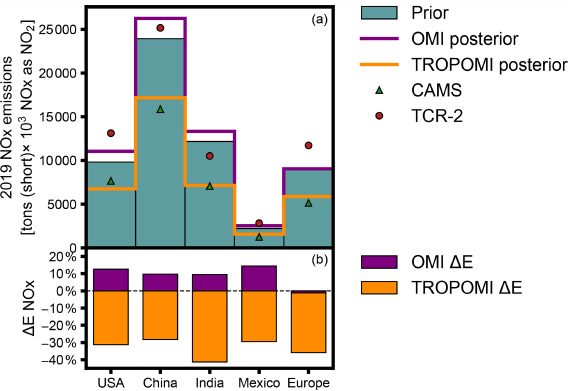
Figure 7. Prior and satellite-inferred 2019 anthropogenic NO x emissions in select global regions. Plot (a) shows total emissions (as NO 2 ) from prior emissions estimates, inference with OMI or TROPOMI observations (OMI and TROPOMI posterior), and CAMS or TCR-2 inventories in the US, China, India, Mexico, and Europe. Plot (b) shows the percent change ( (cid:49)E NO x ) inferred with OMI or TROPOMI data, relative to prior emissions estimates, for each